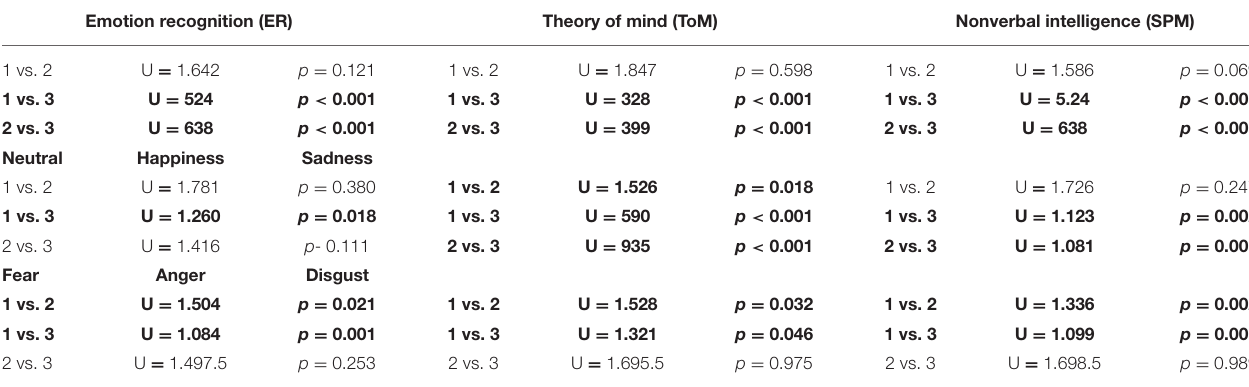
TABLE 4 | Post-hoc analysis between groups (Mann-Whitney U test). Emotion recognition